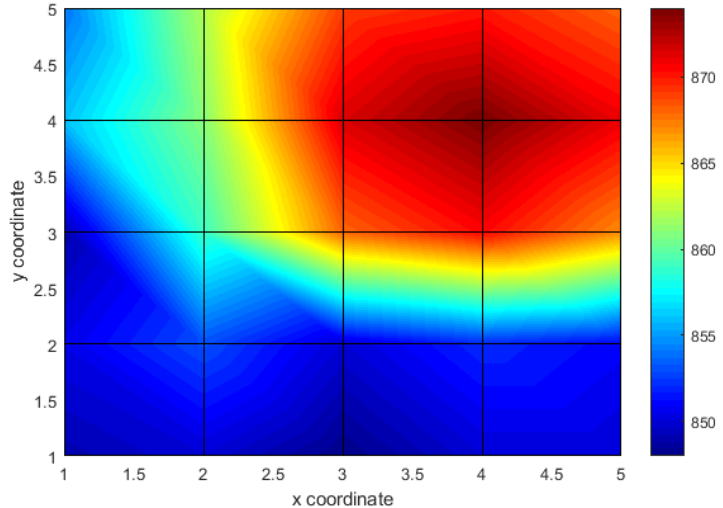
Figure 17. Stress field plan